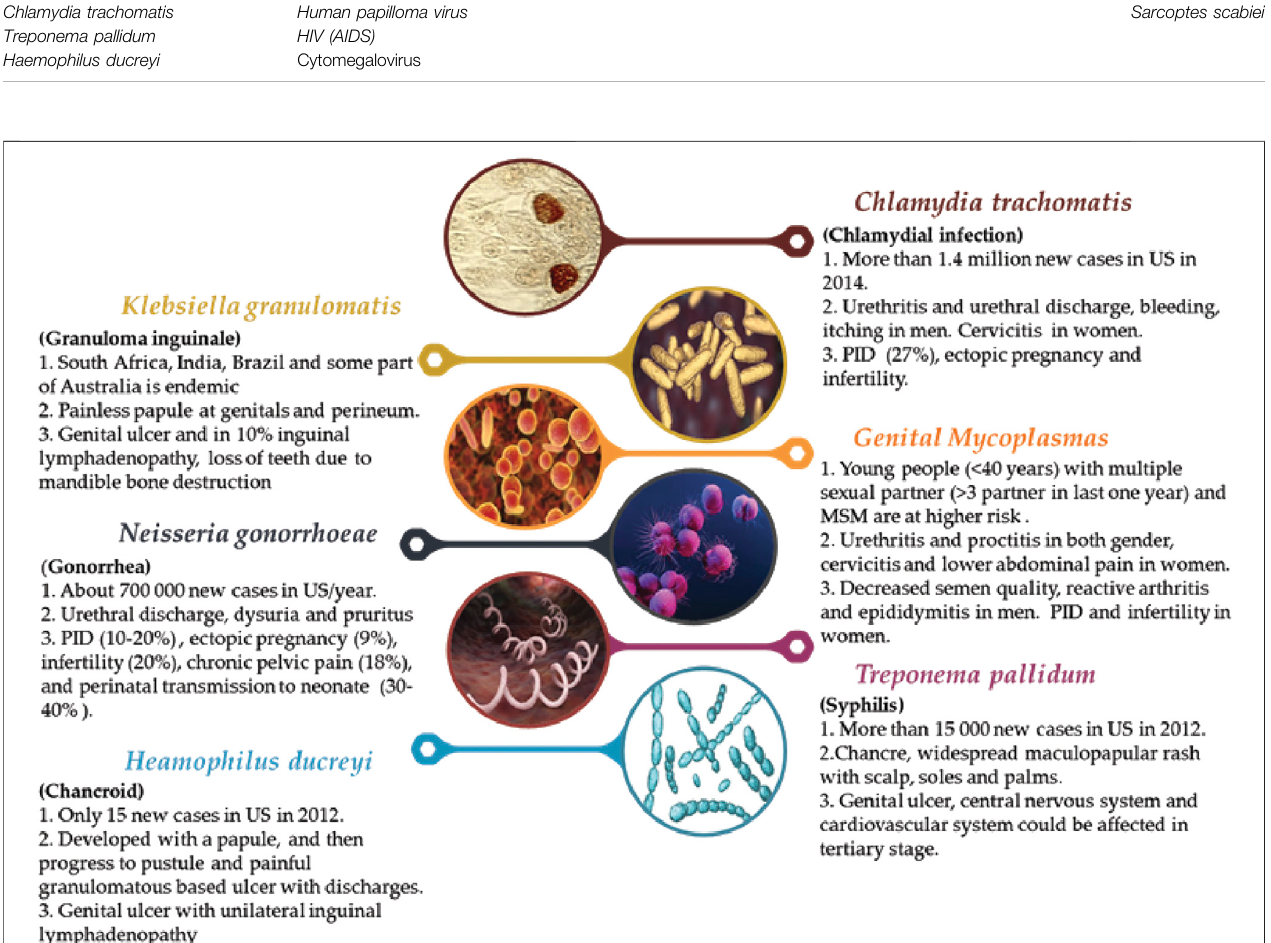
FIGURE 1 | Summary about the major bacteria species that cause STDs (1. frequency for some region, 2. major symptoms, 3. major and possible health effects).